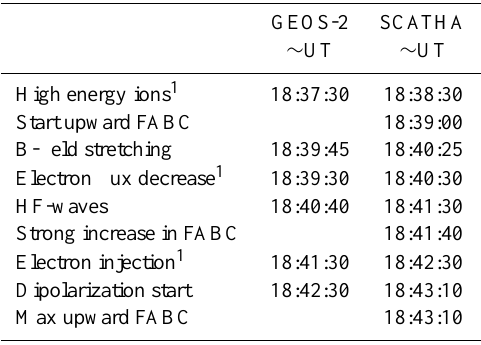
Table 2. Timing of parameter changes at SCATHA and GEOS-2.